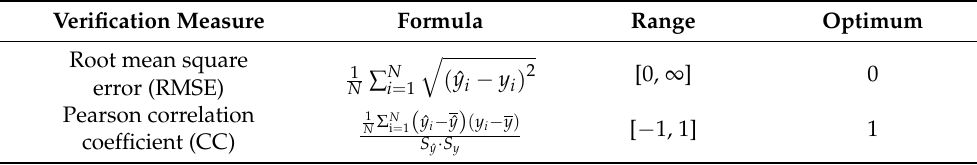
Table 3. Description of regression metrics used. y i is an observation and ˆ y i is its estimation.